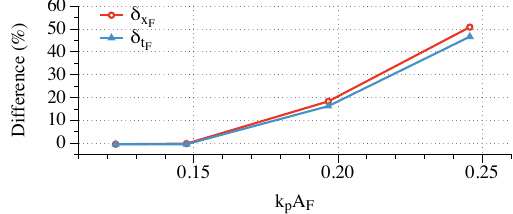
Figure 20. The relative spatial differences in focusing location δ x F and temporal differences in focusing time δ t F in relation to wave steepness in the simulation with the NewWave